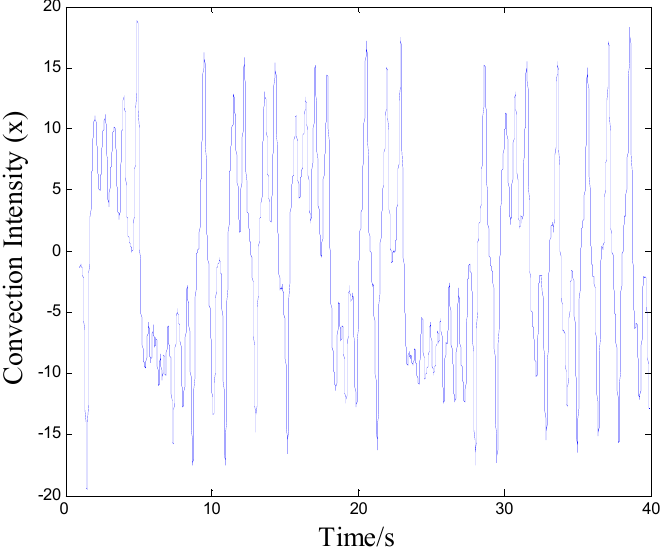
Figure 10. x ( t ) of denoised Lorenz signal with noises.